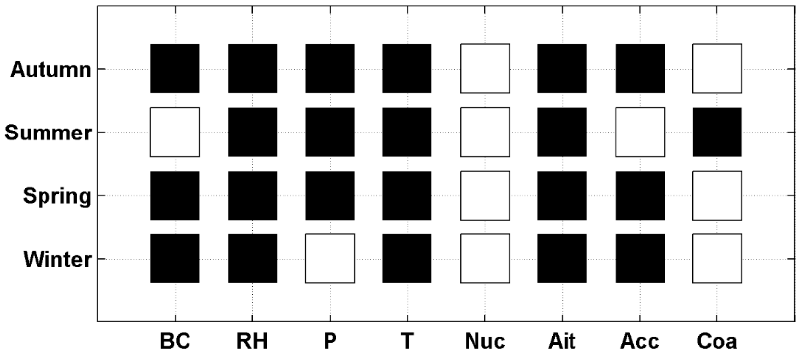
Figure 7. The Wilcoxon–Mann–Whitney test applied on Black Carbon (BC), Relative Humidity (RH), Pressure (P), Temperature (T), Nucleation (Nuc), Aitken (Ait), Accumulation (Acc) and Coarse (Coa) concentrations measured for each season. The squares are black (white) when the medians are significantly different (equal) with a threshold of 5%. Black Crosses are for missing data.